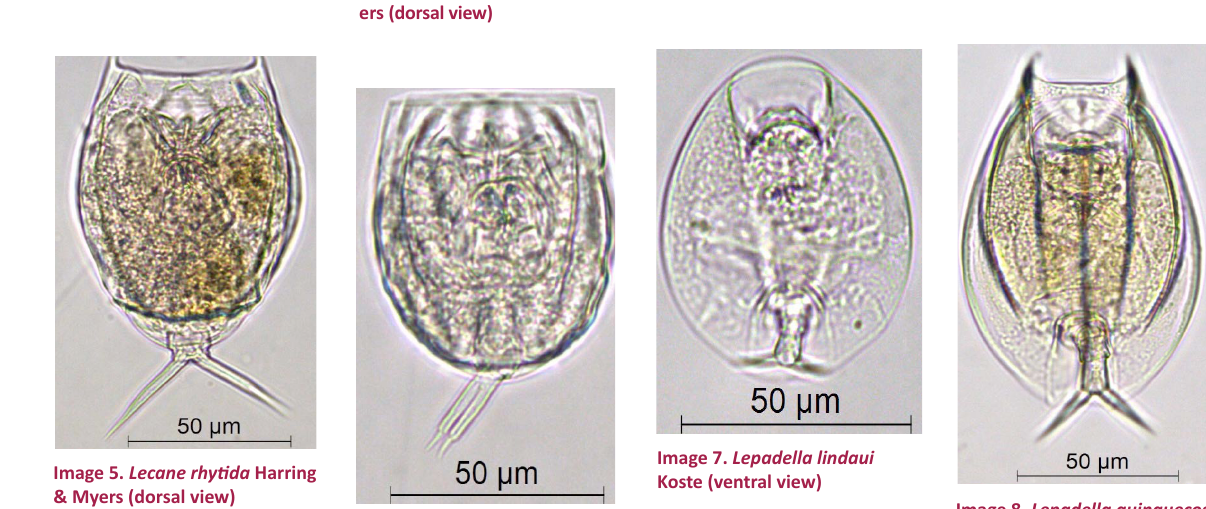
Image 8. Lepadella quinquecos- tata (Lucks) (dorsal view)